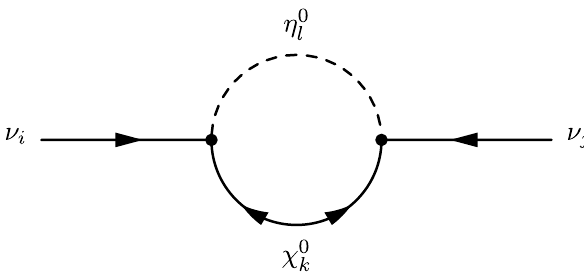
Figure 4 . Feynman diagram for the radiative generation of neutrino masses at the one-loop level after electroweak symmetry breaking and mixing ( k for Feynman diagrams is the same as in ref.